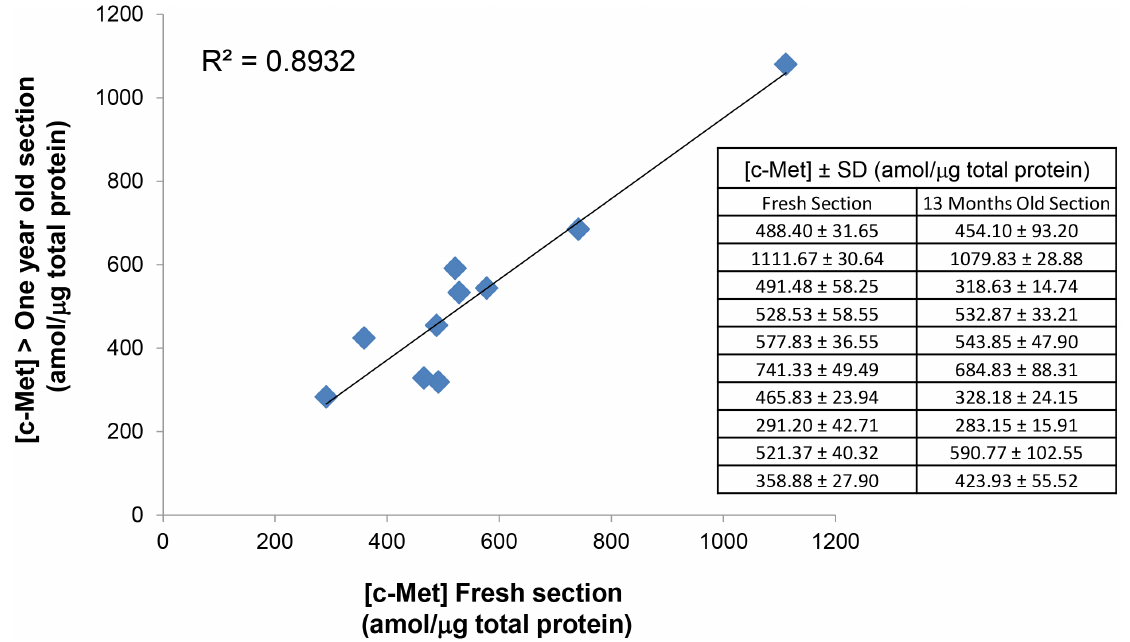
Figure 5. Temporal reproducibility of FFPE sections processed and analyzed using Liquid Tissue-SRM over one year apart. SD, standard deviation.